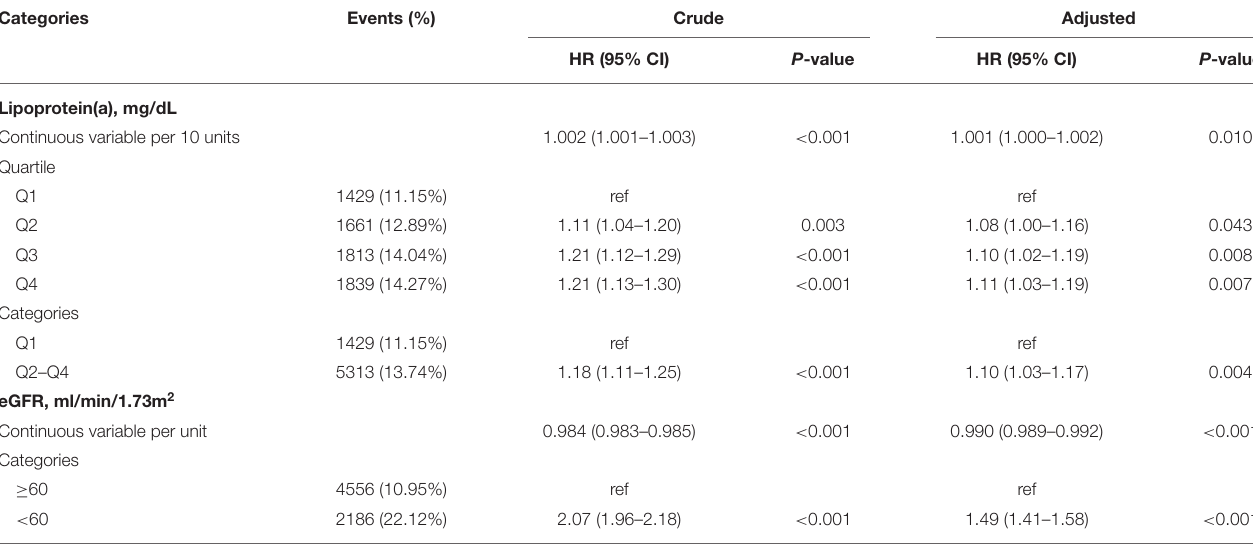
TABLE 2 | Lipoprotein(a) and eGFR in relation to all-cause mortality,